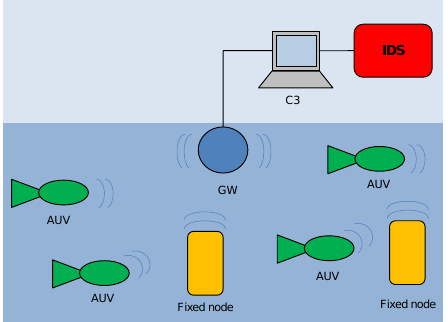
Figure 1. The surveillance